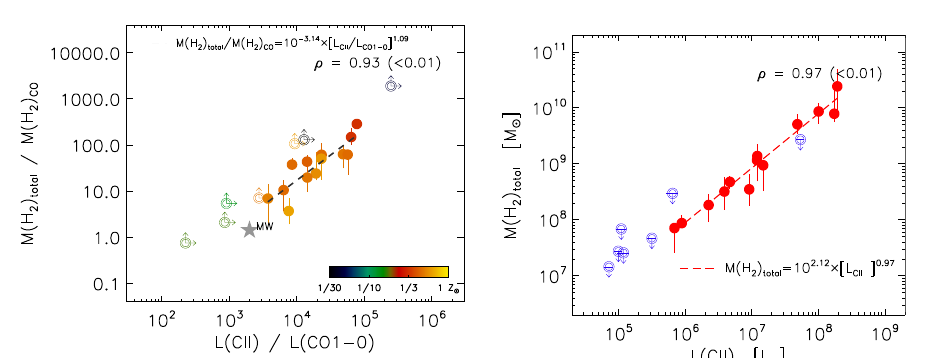
determined from the model over the M H 2 2 ) total vs. observed [C 0) relates to the depth of the molecular cloud and the −